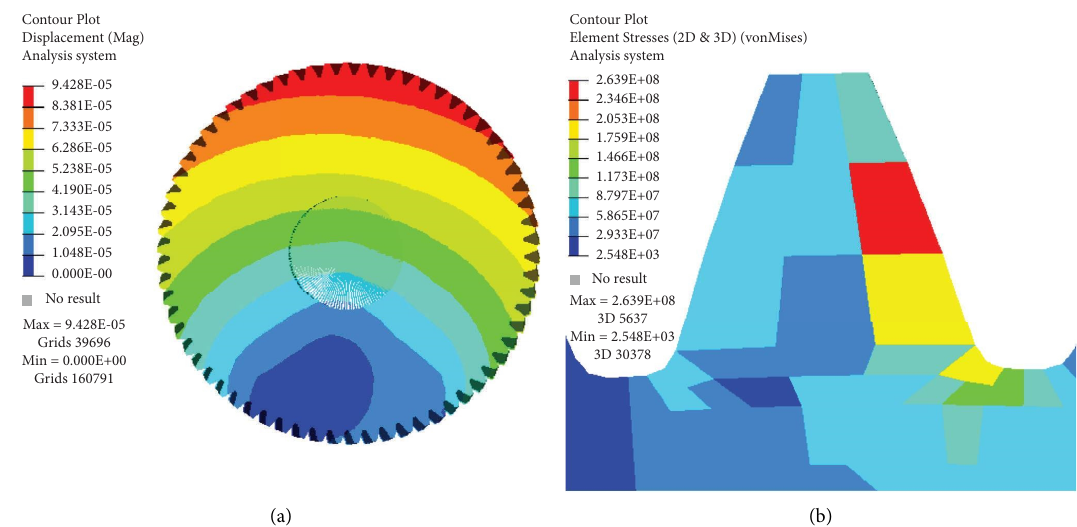
Figure 4: Schematic of gear statics analysis results. (a) Schematic of gear displacement cloud. (b) Schematic of gear Von Mises stress